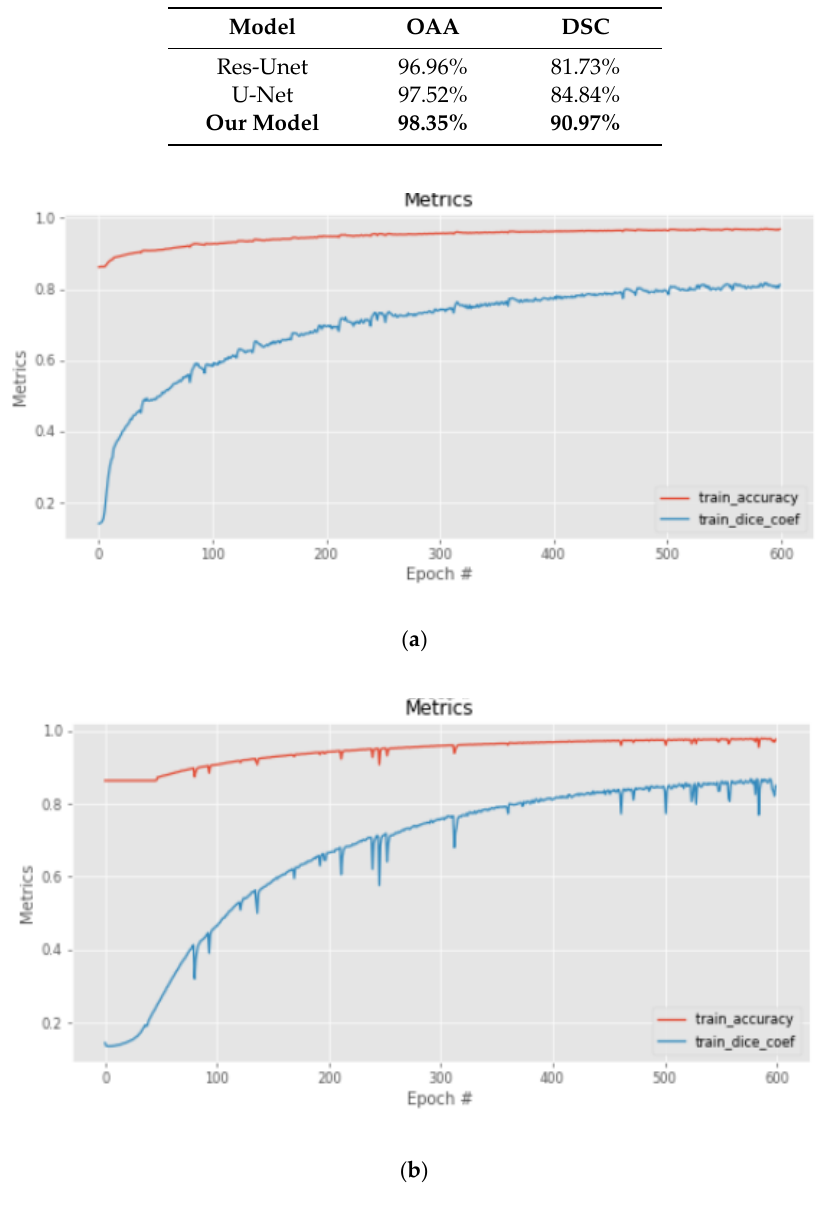
Figure 4. Comparisons of the OAAs and DSCs for ( a ) the Res-Unet and ( b ) the U-Net.